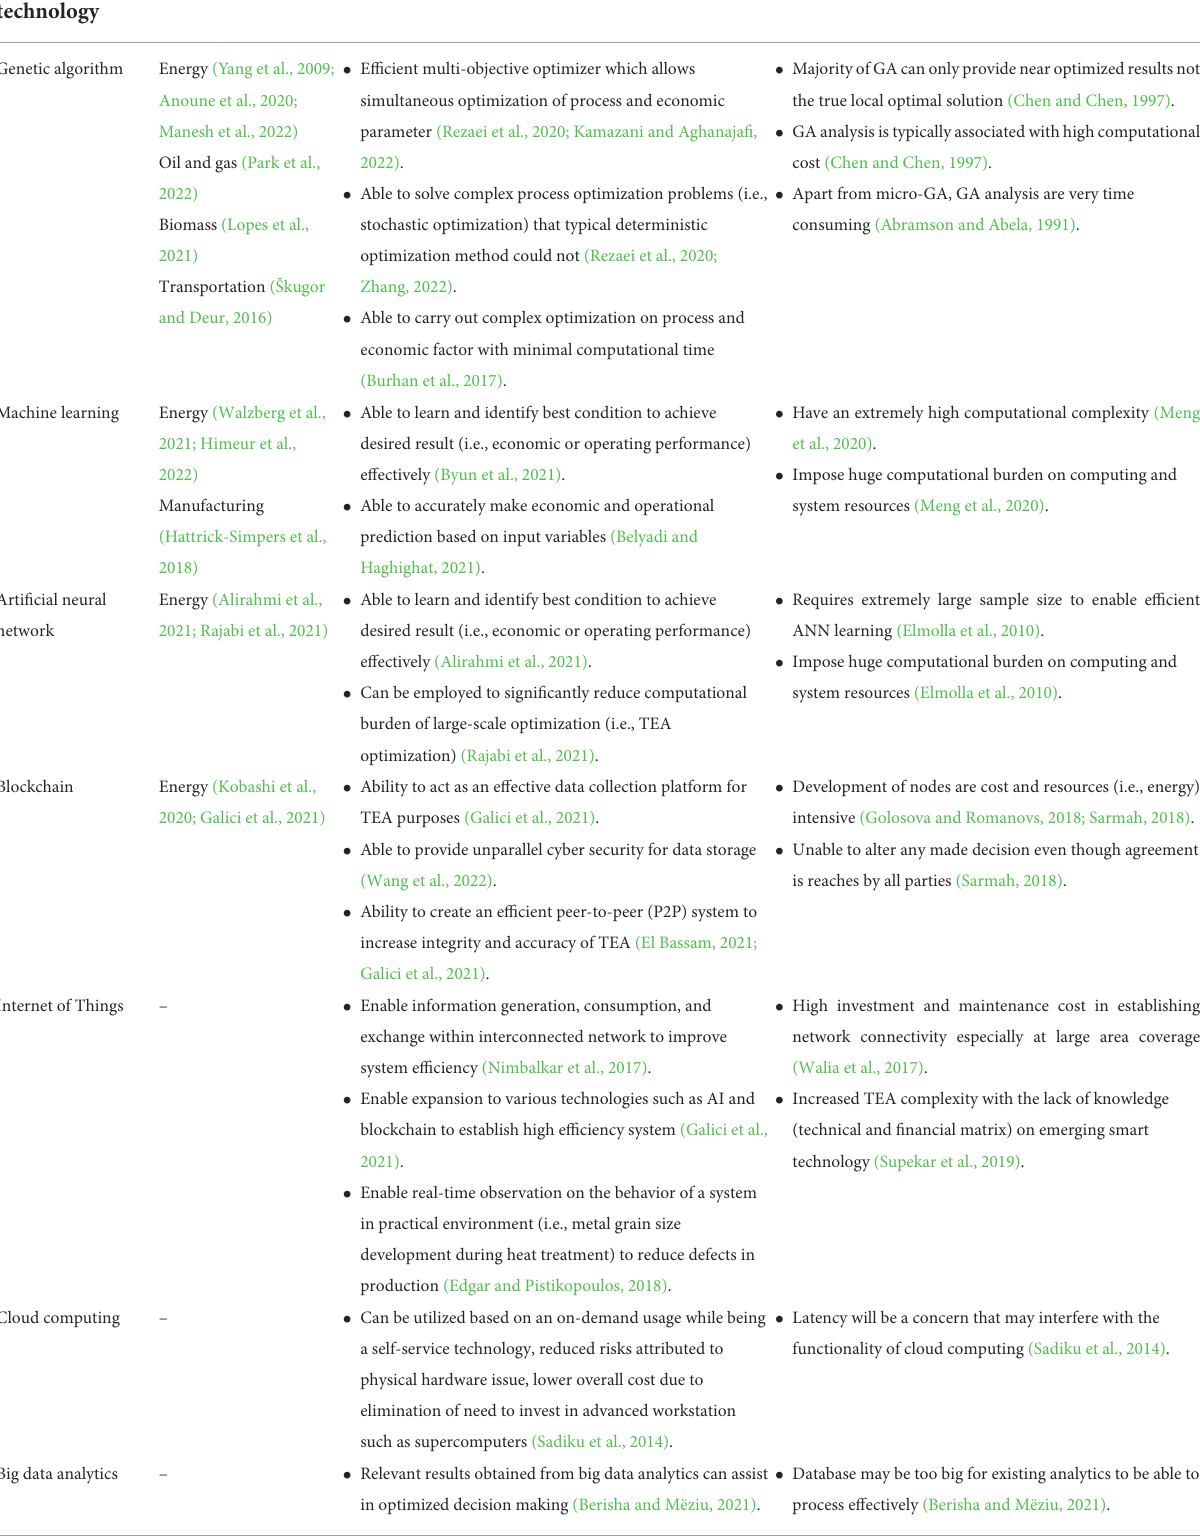
TABLE 3 Summary of the past and potential data-driven application in